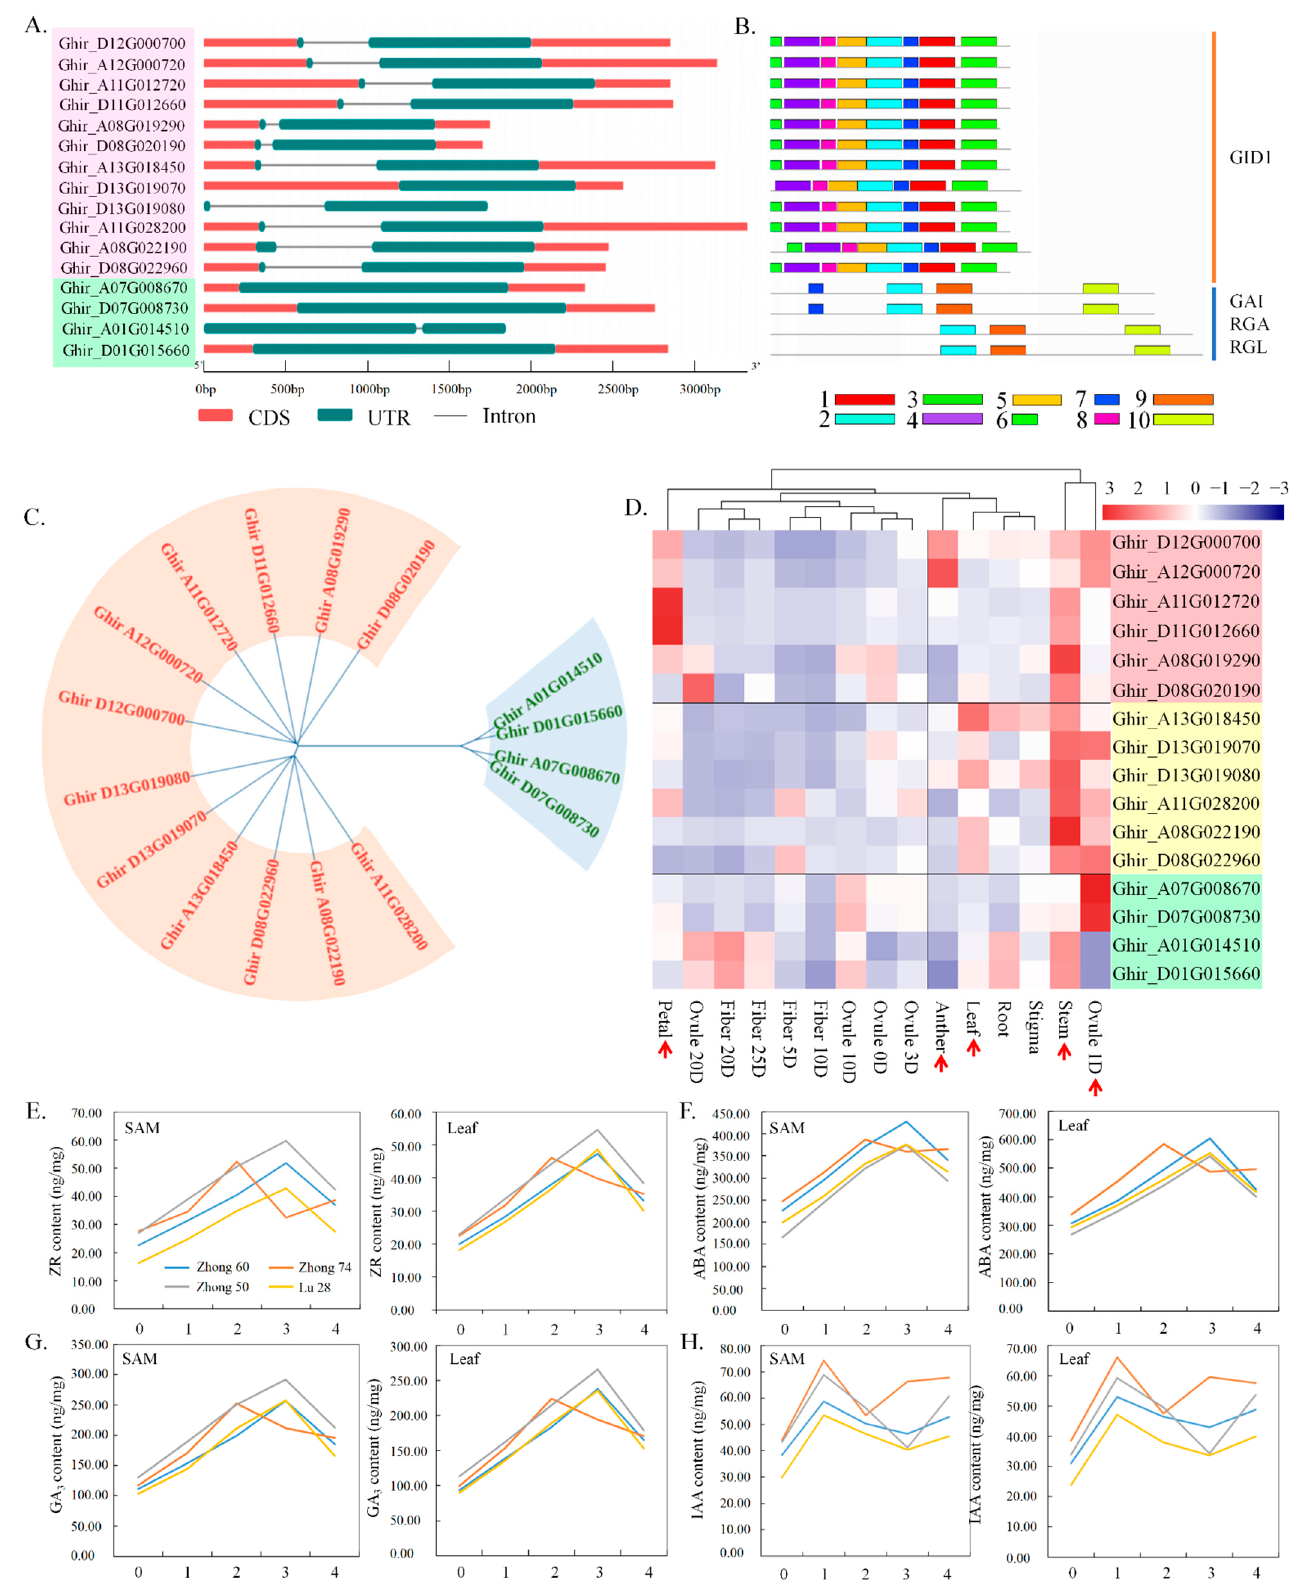
Figure 4. Distribution of conserved motifs and exon–intron structure, and expression level analysis of Ho pathway flowering-related genes. ( A ) Exon–intron structure of G. hirsutum flowering-related genes involved in the Ho pathway, as revealed by TBtools software. ( B ) Distribution of conserved